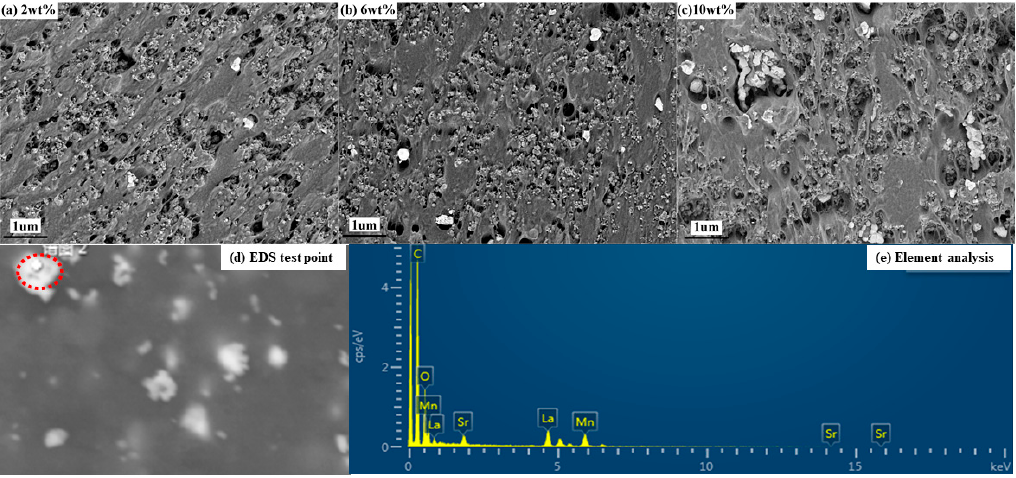
Figure 7. The SEM images and element analysis of La 0.8 S r0.2 MnO 3 / semi-conductive composites. ( a ) LSM content 2 wt. %; ( b ) LSM content 6 wt. %; ( c ) LSM content 10 wt. %; ( d ) sampling point of EDS test ( e ) element analysis.